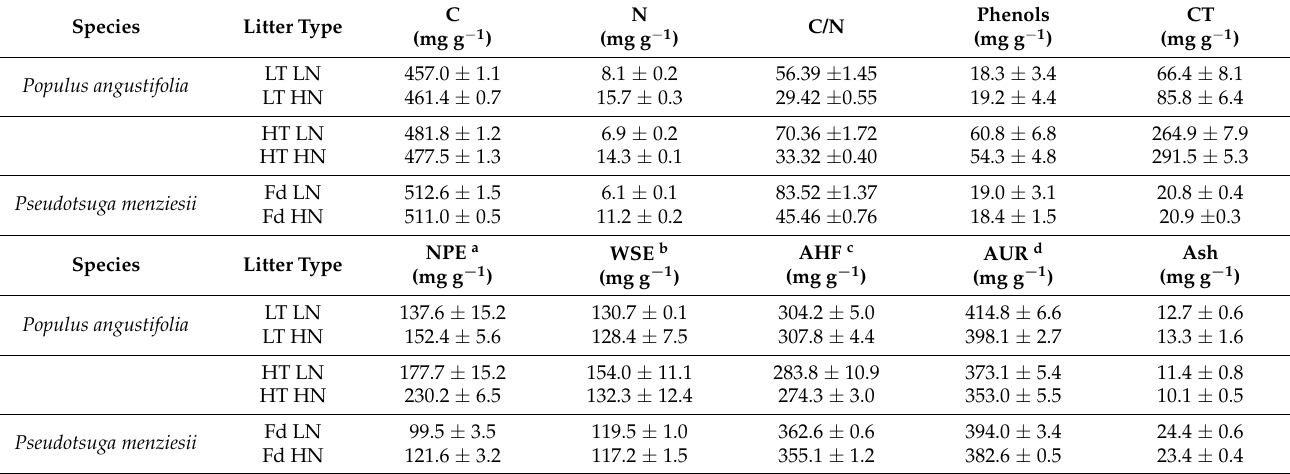
Table 1. Initial litter chemistry of Pseudotsuga menziesii (fir = Fd) and Populus angustifolia (poplar) leaf litter with low and high nitrogen (LN and HN) and condensed tannins (LT and HT, poplar only), including carbon (C), nitrogen (N) and their ratio (C/N), phenols, total condensed tannins (CT) and proximate chemistry. Mean values for each litter type were used for modeling microbial community responses during decay. Values ( ± SE) are based on dry weight (70 ◦ C overnight) and calculated from 6 and 4 replicates (for poplar and Fd litter, respectively) or 3 replicates (for proximate chemical